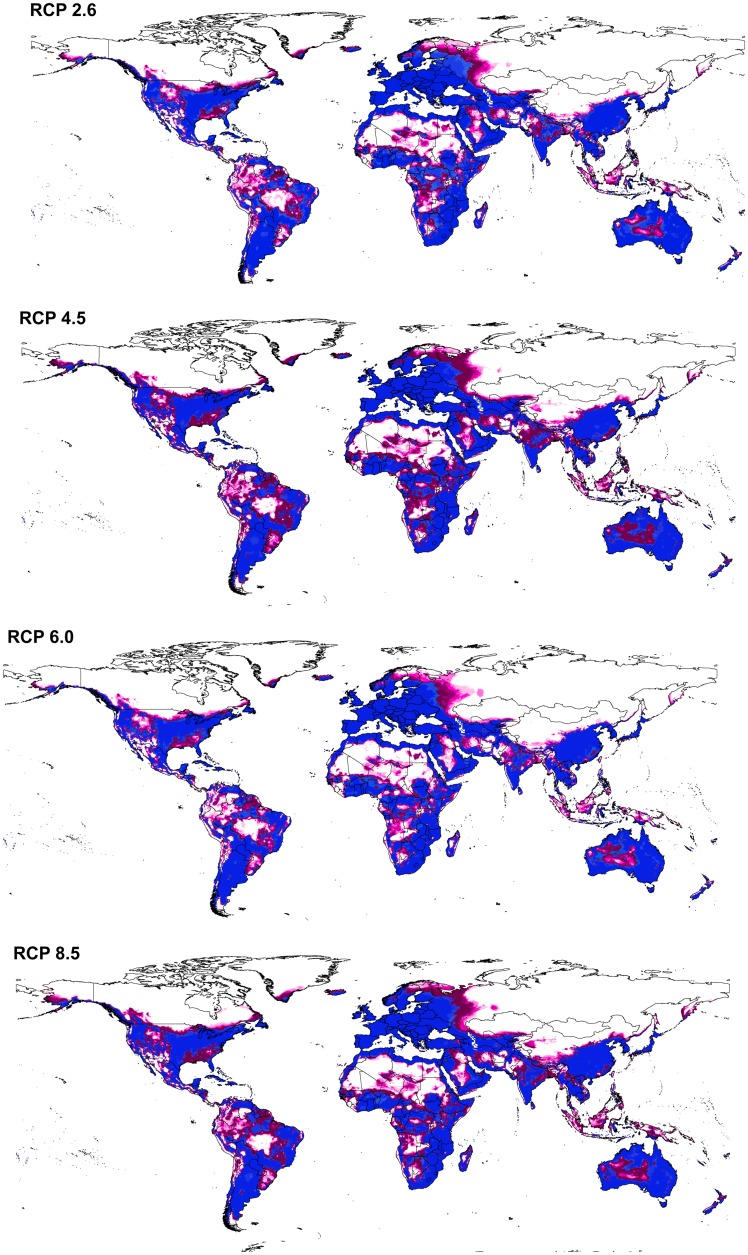
Summary of the modeled global distribution of bluetongue virus under both current and future climatic conditions to show the stability of predictions at present and into the future, and to illustrate differences among representative concentration pathways (RCPs).Dark blue represents model stability under both current and future conditions, light blue represents low agreement between current and future conditions, dark purple represents agreement among all climate models in anticipating potential distributional areas in the future, and light purple indicates low agreement between diverse climate models as regards distributional potential in the future.